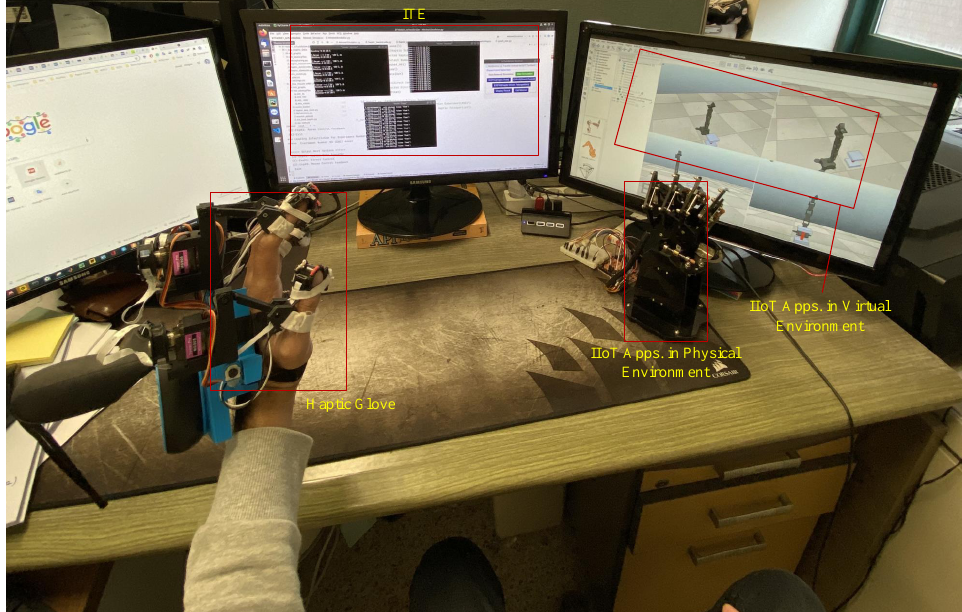
Figure 15. Modular representation of ITE in real-world